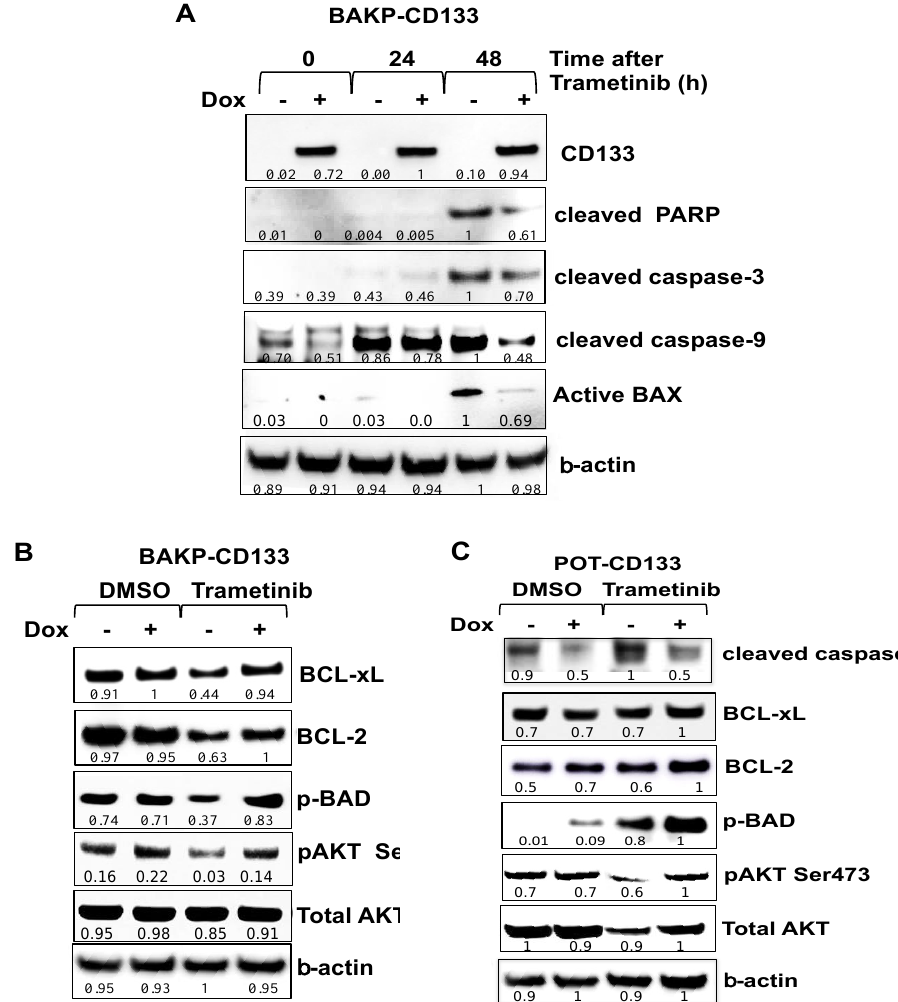
Figure 6. Dox-inducible CD133 expression attenuates trametinib-induced apoptosis in BAKP-CD133 ( A , B ) and POT-CD133 cells ( C ), as evidenced by reduced PARP cleavage, proteolytic activation of caspases-3 and -9, and activation of BAX ( A ), and upregulation of anti-apoptotic proteins BCL-xL, BCL-2, p-BAD, and p-AKT ( B ), in response to trametinib treatment. ( A ) BAKP-CD133 cells were exposed to 100 nM trametinib for 24 or 48 h +/− Dox, followed by immunoblot analysis with antibodies to apoptotic markers cleaved PARP, cleaved caspase-3, cleaved caspase-9, and active Bax. BAKP-CD133 ( B ) and POT-CD133 ( C ) treated with 100 nM trametinib +/ − Dox were subjected to immunoblot analysis with anti-apoptotic proteins BCL-xL, BCL-2, p-BAD, p-AKT, AKT, and β -actin for normalization. Densitometric analysis comparing intensities of protein bands relative to bands with the highest intensity is shown below each band in immunoblots. 2.6. Targeting Nodes of the CD133, AKT, and BCL-2 Family Survival Pathway, and/or Tra-